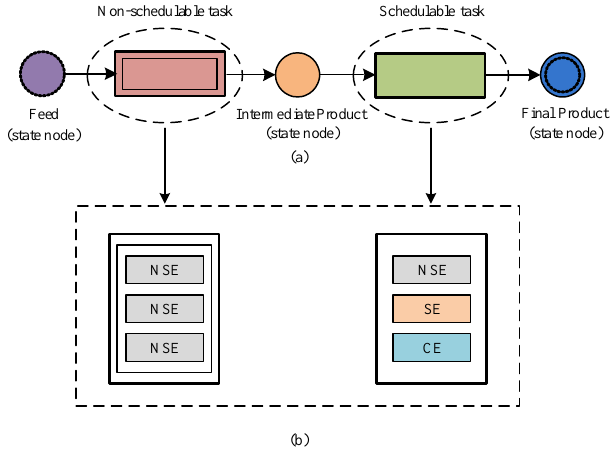
Figure 1. ( a ) Simple representation of a demand response (DR) model and ( b ) internal structure of each task with corresponding industrial equipment.